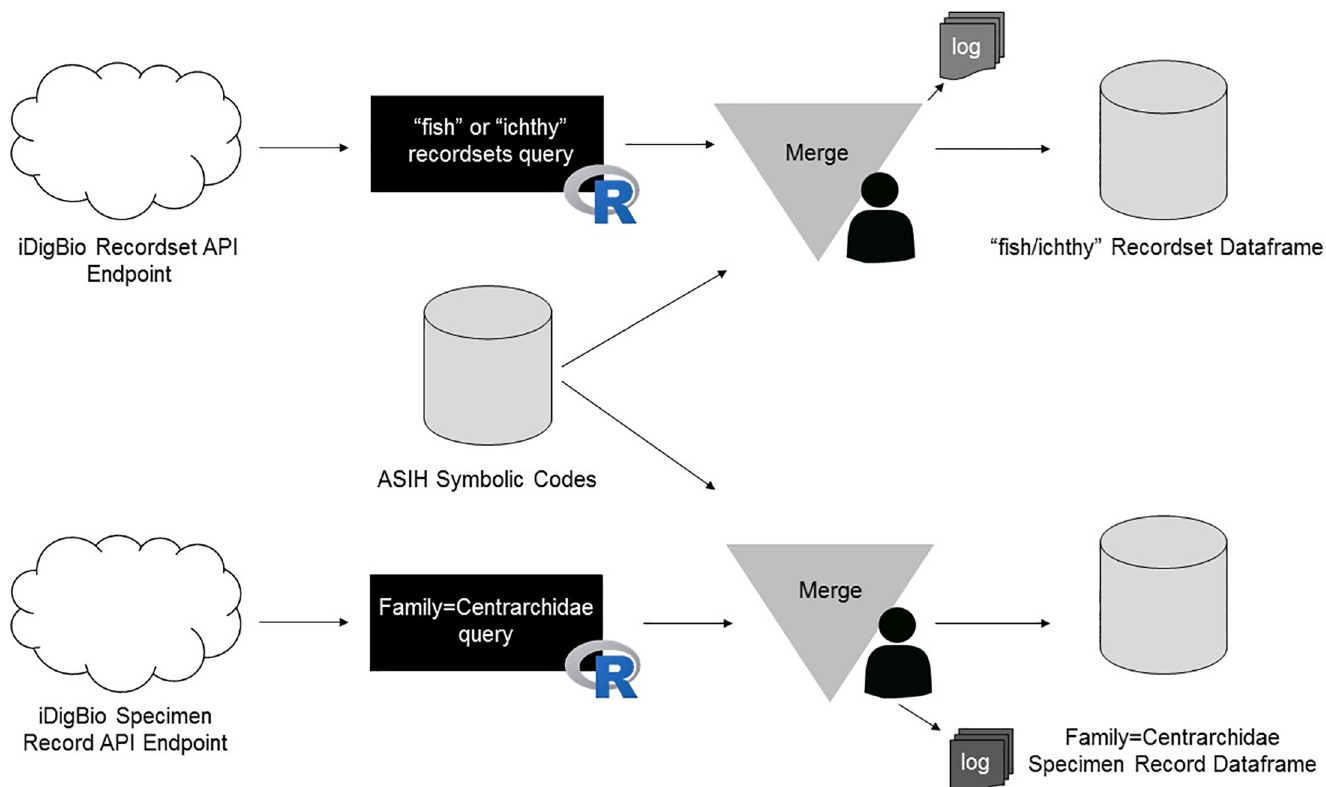
Fig 1. First approach workflow for discovering fish collections. Searches were run using the terms “fish” and “ichthy” alongside recordsets containing “Family = Centrarchidae” contained in iDigBio published recordsets.